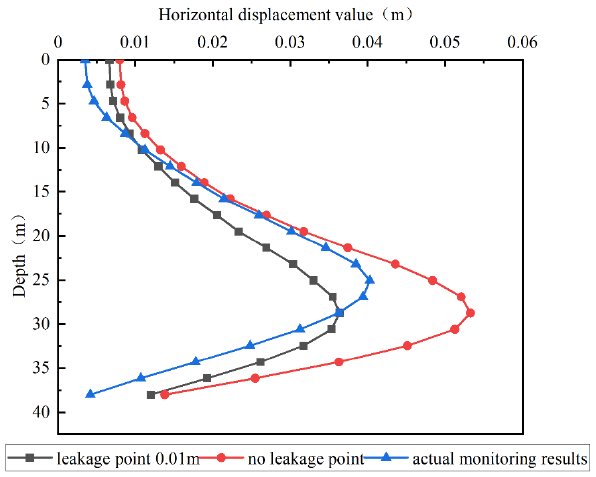
Figure 27. Comparison between numerical simulation and measured horizontal displacement of envelope structure.